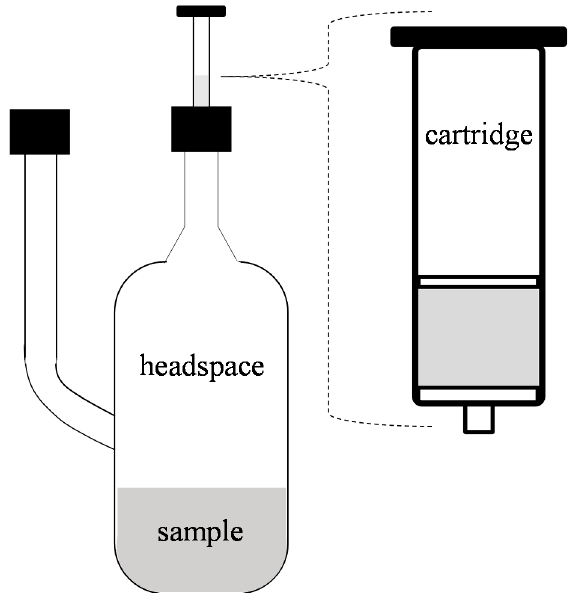
Figure 1. Headspace system coupled to a solid phase (SPE) with a cartridge used for the isolation of aroma compounds by the SPE method for extracting fruit pulp components. Adapted from San-Juan, Pet’Ka, Cacho, Ferreira, and Escudero [27]; Zapata et al.